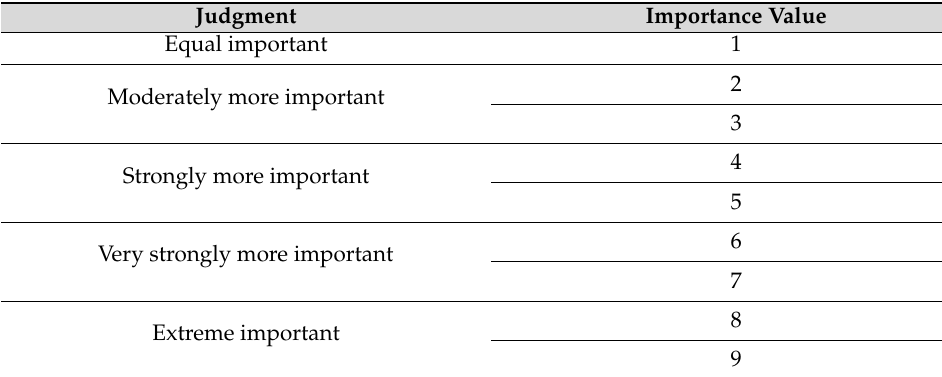
Table 6. AHP pairwise comparison